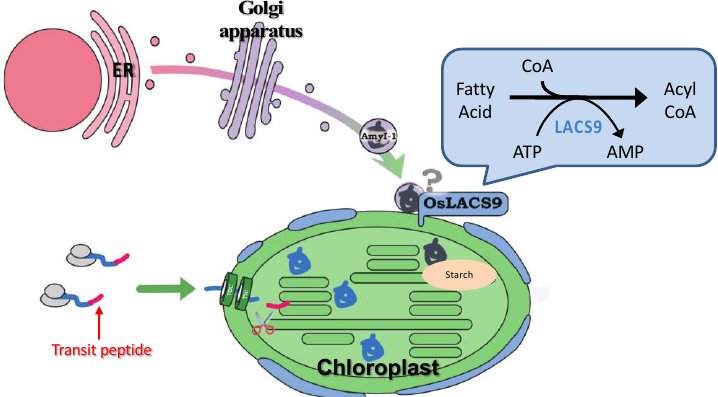
Figure 8. Hypothetical model of plastid targeting of glycoproteins through the secretory pathway. OsLACS9 is localized exclusively in the plastid envelope of leaf mesophyll cells and nearby vesicle-like structures. OsLACS9s interact with each other and with as yet unidentified components that might be involved in the plastid targeting mechanism of glycoproteins (i.e., AmyI-1) via the secretory pathway. According to this suggested model, OsLACS9 may permit e ffi cient starch degradation and contribute to optimal plant